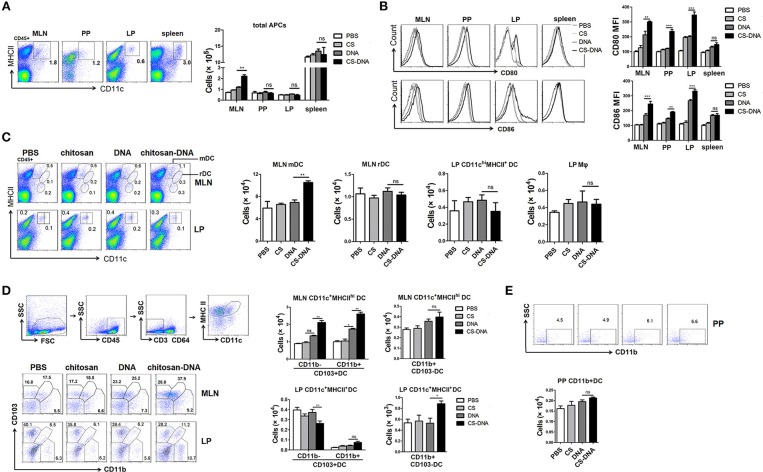
Intranasal chitosan-DNA immunization recruits CD103+DCs into the MLNs. (A) Representative flow cytometry plots of SI-LP, PP, MLN DC, and spleen DC in BALB/c mice 24 h after DNA or chitosan-DNA immunization. Cells are pre-gated on live, CD45+ cells. Absolute cell numbers of CD11c+MHCII+ cells from various lymphoid organs were summarized in the bar graph. Data are mean ± SEM (n = 6) from three independent experiments. **P < 0.01. (B) Representative histogram depicting the increase in mean fluorescence intensity of CD80 and CD86 on CD11c+MHCII+ DCs in various GALTs. Cumulative MFI units data for CD80 and CD86 expression were shown. Data are mean ± SEM (n = 6) from three independent experiments. ***P < 0.001; **P < 0.01. (C) Intestinal DC subset composition. Representative flow cytometry plots (left panel) and cell numbers (right panel) of CD11cintMHCIIhi MLN migratory DCs (mDCs), CD11chiMHCII+ MLN resident DCs (rDCs) and CD11chiMHCII+ LP mDCs, CD11cmedMHCII+ LP macrophages from DNA or chitosan-DNA-immunized mice were shown. Data are mean ± SEM (n = 6) from three independent experiments. **P < 0.01. (D) Representative flow cytometry plots of CD103+CD11b−DC and CD103−CD11b+DC subsets after excluding CD64+ macrophages from CD11c+MHCIIhigh cells. (E) CD11c+MHCII+ PP DCs were further evaluated for expression of CD11b. Cell numbers of CD103+CD11b+ and CD103+CD11b− DC and CD11b+DC subsets in the MLNs, LPs and PPs of mice were cumulated in bar graph. Data are mean ± SEM (n = 6) from three independent experiments. **P < 0.01; *P < 0.05; ns, not significant.